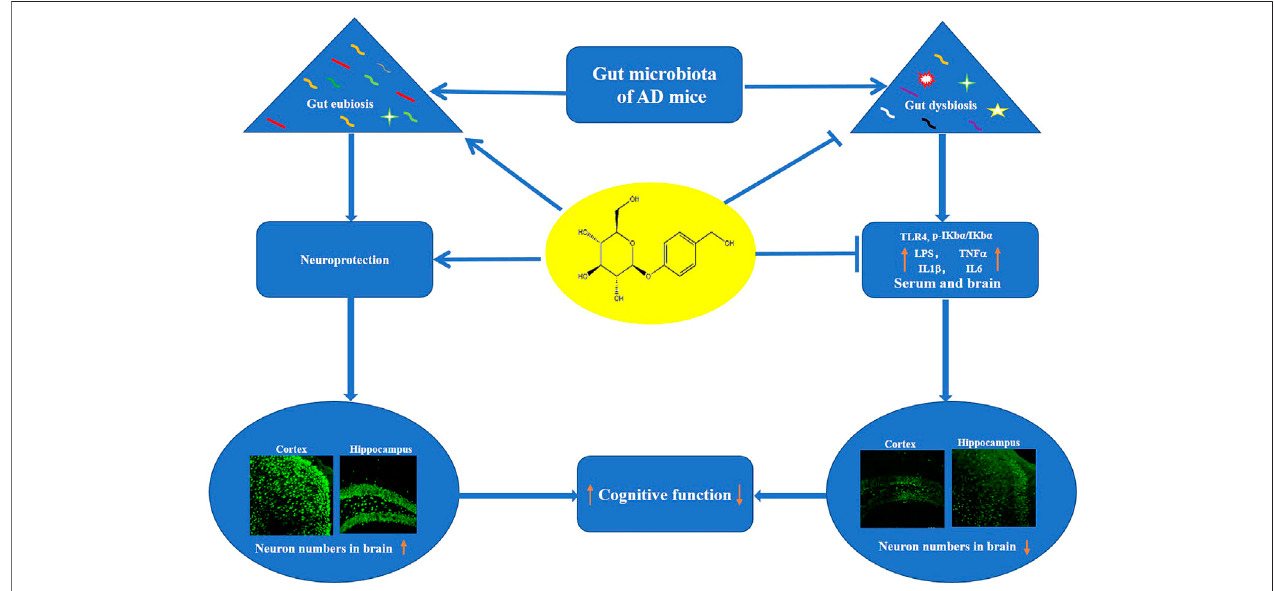
FIGURE 9 | Proposed mechanism of action of Gas. Gas improved the memory of Dgal-induced AD mice via regulating the composition of gut microbiota and inhibition of neuroin fl